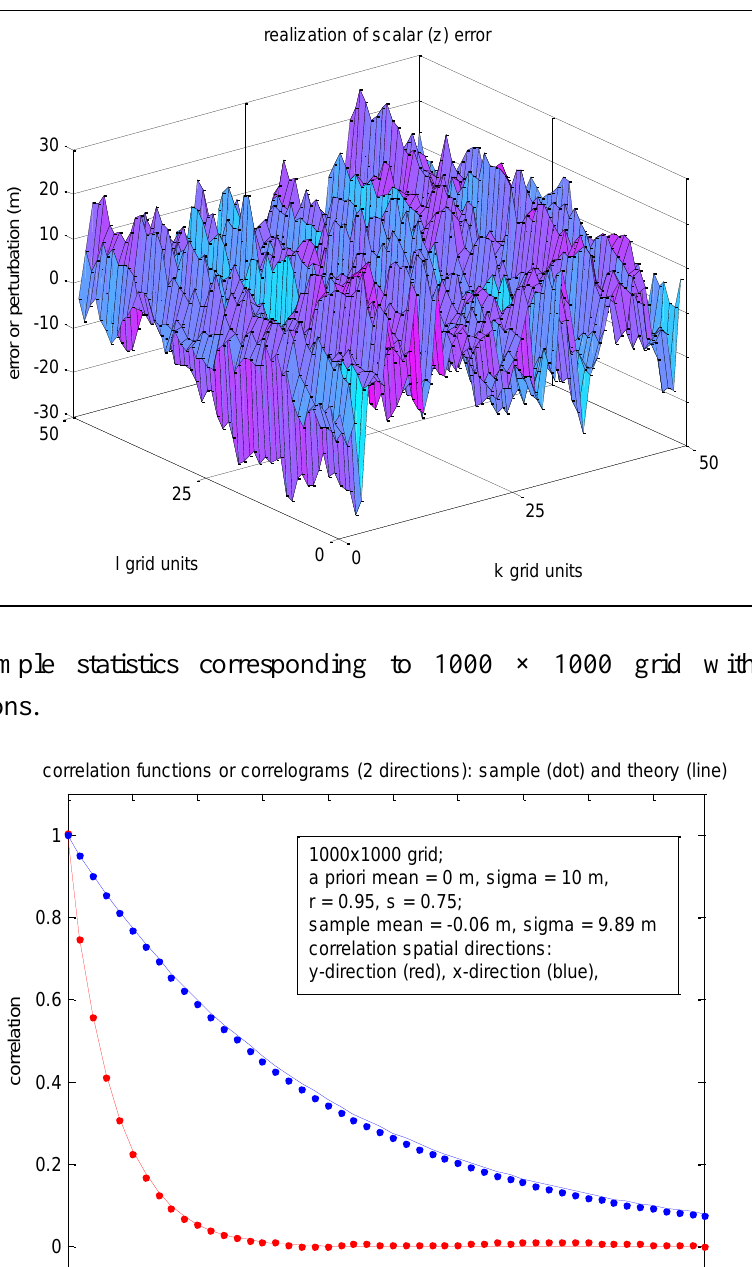
Figure 7. Example 4—Realization of -error with different spatial correlations.